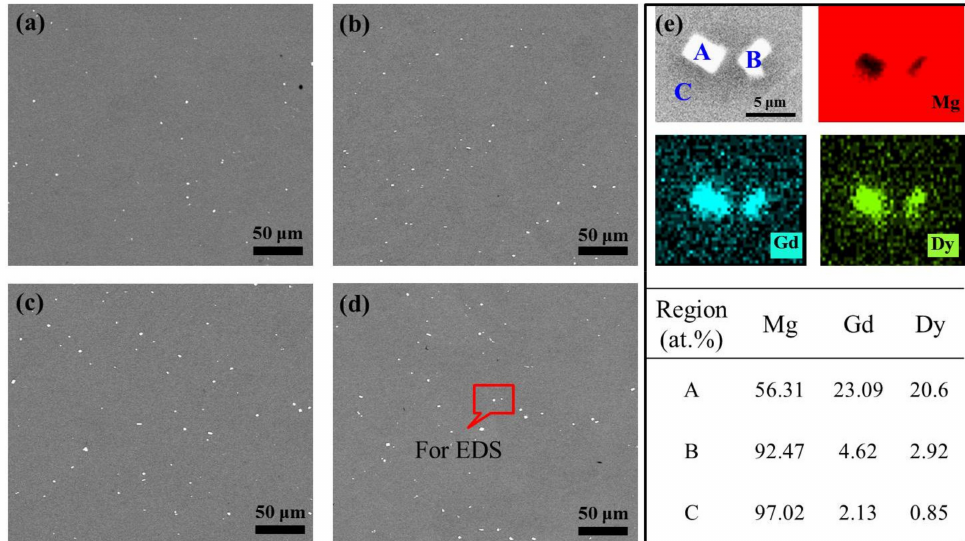
Figure 4. Microstructure characterization of the as-extruded Mg–Gd–Dy–Zr alloys: SEM images of ( a ) GD0.6, ( b ) GD1.2, ( c ) GD5.0, ( d ) GD10.0, and ( e ) EDS analysis of the selected area in ( d